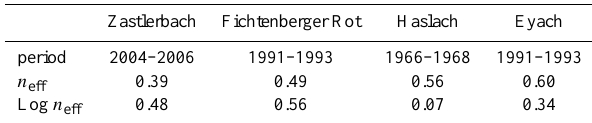
Table 4. Best parameter sets and maximum Kappa value for the optimization of the four catchments.